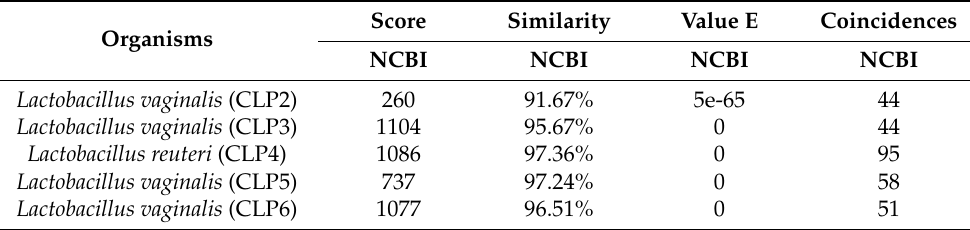
Table 1. Sequencing of bacterial isolates by 16s rRNA from cecal content in Creole rooster. Organisms